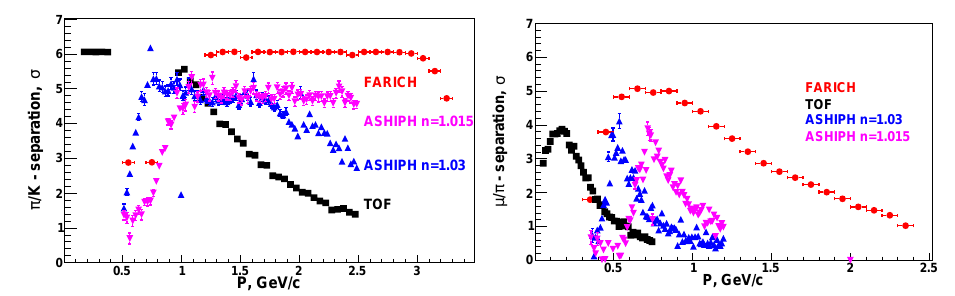
Figure 13. µ / π -separation in terms of standard deviation ( σ ) for several PID options obtained with help of parametric simulation: